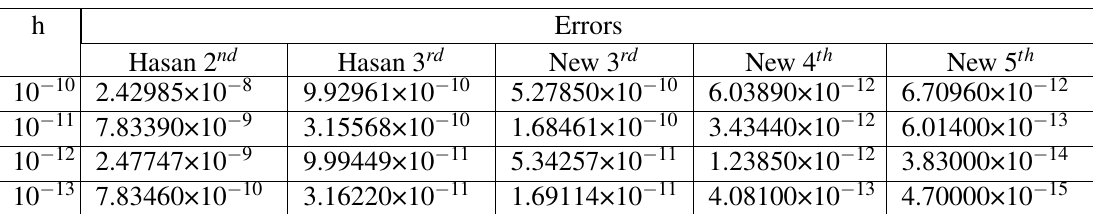
Table 4.1 (e): Absolute errors of the solution of Eq. (21) at x = 0 . 0000000001 by Hasan’s [13, 16] methods and new methods with Romberg scheme.